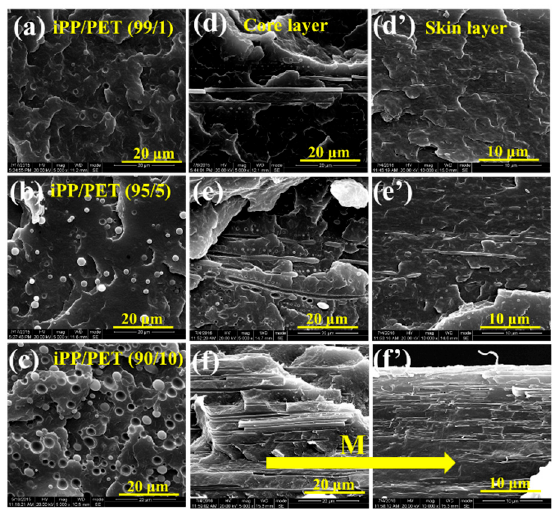
Figure 3. Scanning electron microscopy (SEM) images of iPP/PET blends: melt-blended specimens ( a – c ) and M-parts with ( d – f’ ). The mold temperature is 120 °C. M represents the flow direction.